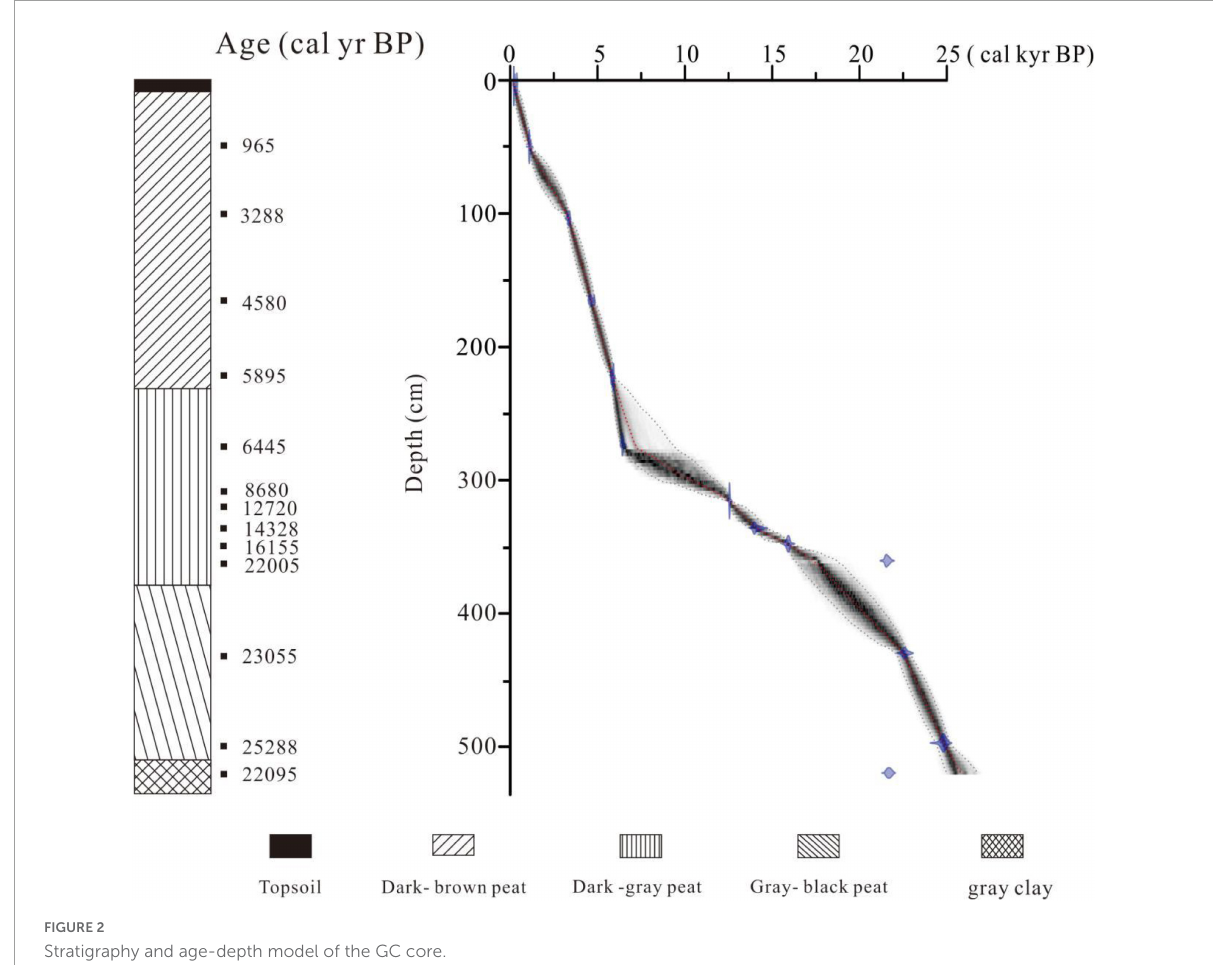
FIGURE2 Stratigraphy and age-depth model of the GC core.